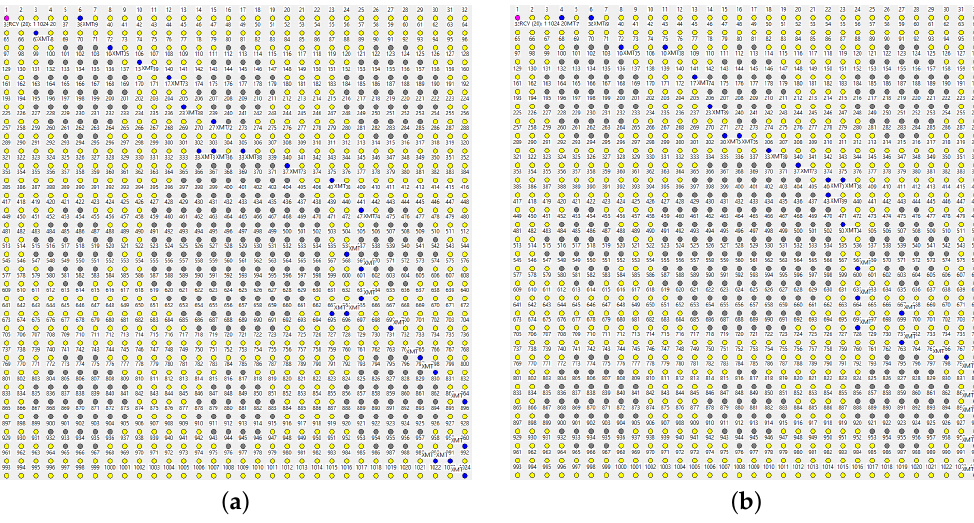
Figure 10. Two consecutive paths around nine holes following a fresh beacon. ( a ) Path one; ( b ) path